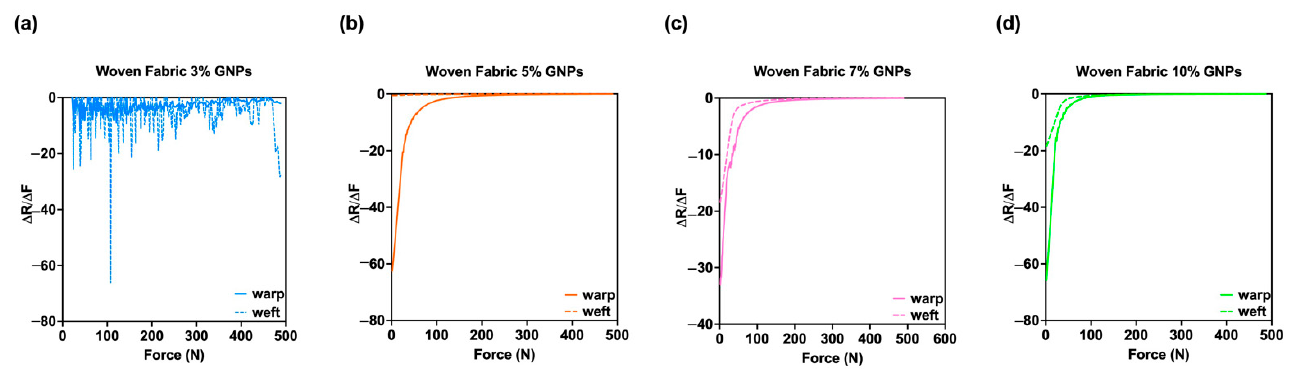
Figure 18. Sensitivity (S) of ( a ) woven fabric doped with 3% GNPs, whose active material was assembled towards the walewise (continuous line) and towards the coursewise directions (dotted line) both are represented by the colour blue; ( b ) woven fabric doped with 5% GNPs, whose active material was assembled towards the walewise (continuous line) and towards the coursewise directions (dotted line), both are represented by the colour orange; ( c ) woven fabric doped with 7% GNPs, whose active material was assembled towards the walewise (continuous line) and towards the coursewise directions (dotted line), both are represented by the colour pink; ( d ) woven fabric doped with 10% GNPs, whose active material was assembled towards the walewise (continuous line) and towards the coursewise directions (dotted line), both are represented by the colour green.